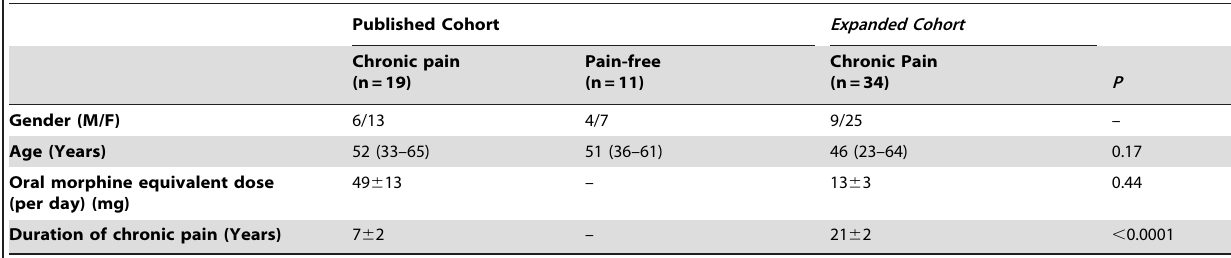
Table 8. Demographic summary.